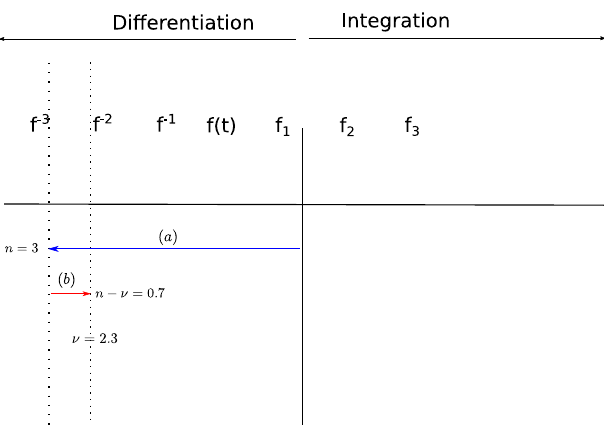
Fig. 2 Graphical Representation of Right-hand definition of fractional derivative of order ν = 2 .